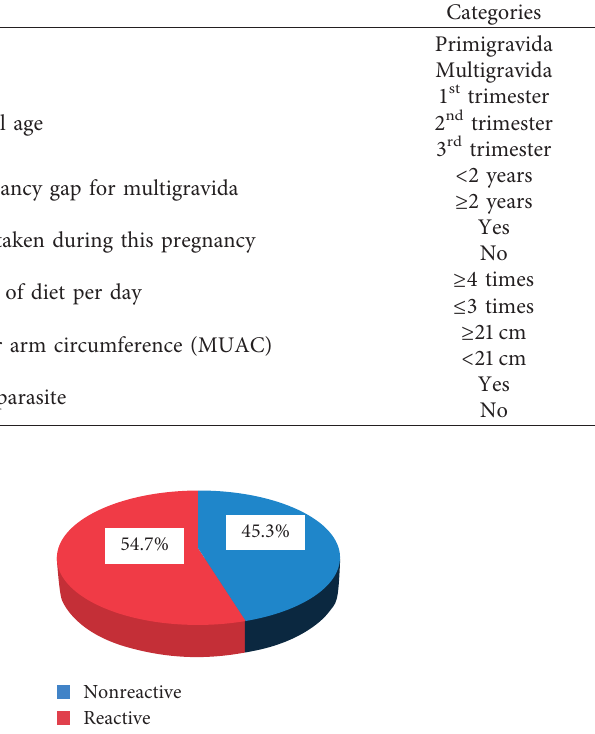
Table 2: Obstetric history and nutritional characteristics of the participants in Kulito Health Center, SNNPR, Ethiopia, 2018 ( n � 236).